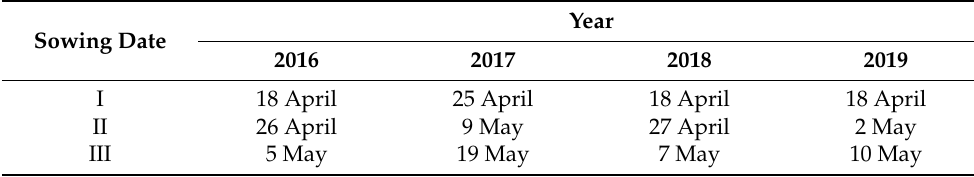
Table 1. The soybean sowing dates from 2016 to